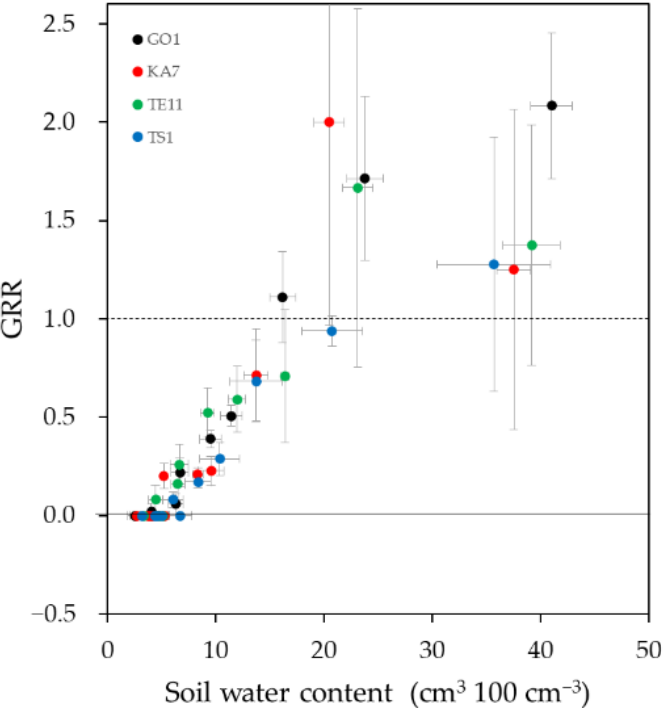
Figure 5. Relationship between the soil water content and growth rate ratio (GRR). Black, red, green, and blue symbols correspond to the clones GO1, KA7, TE11, and TS1, respectively.